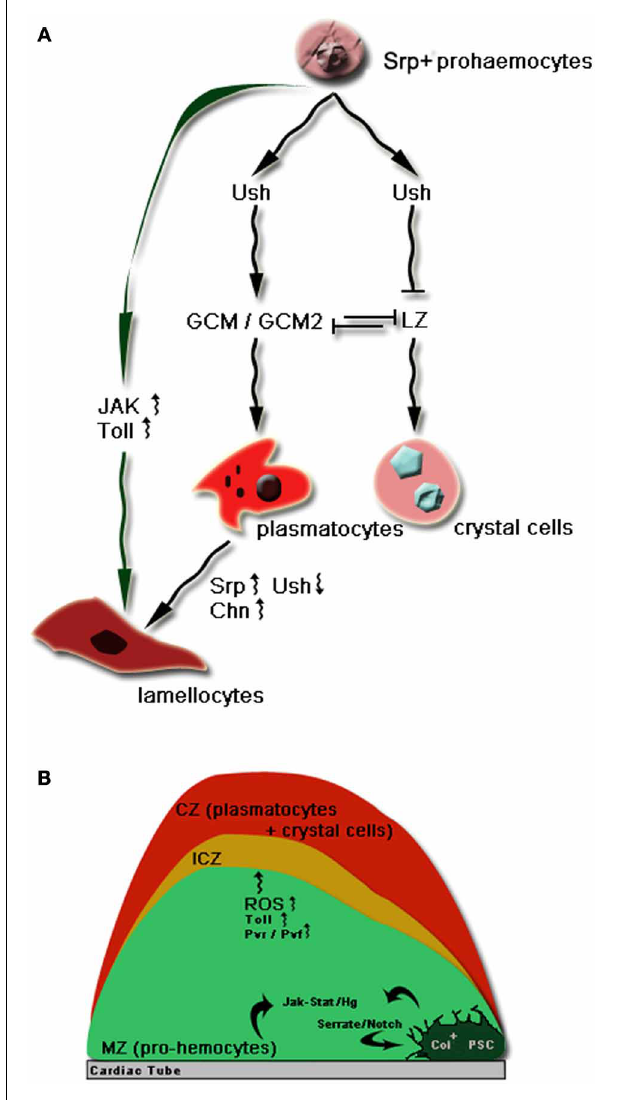
FIGURE 2 | (A) The major transcriptional network in the lineage commitment of Drosophila prohaemocytes (Lebestky et al., 2000;